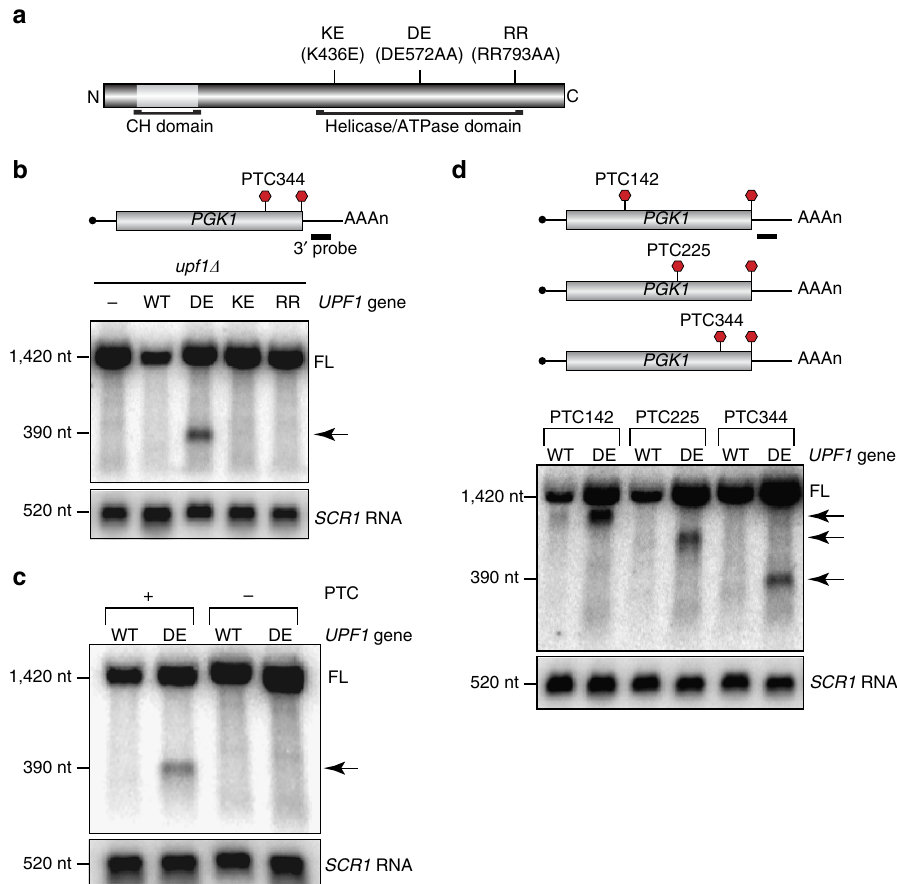
Figure 1 | Accumulation of a 3 0 RNA fragment from nonsense-containing mRNA in UPF1 ATP hydrolysis mutants. ( a ) Schematic diagram of point mutations within the C-terminal helicase domain of UPF1 that impair ATP binding (K436E), ATP hydrolysis (DE572AA) or RNA binding (RR793AA). The cysteine/histidine-rich domain (CH) within the N-terminus of UPF1 is indicated. ( b – d ) Northern blot analysis of PGK1 reporter mRNA in upf1 D cells ( (cid:2) ) complemented with wild-type (WT) or mutant UPF1 using a probe complementary to the mRNA 3 0 end. Reporter mRNA either harboured a PTC within its 416 codon open reading frame ( b – d ) or lacked a PTC ( c ; (cid:2) ). Full-length reporter mRNA (FL) and 3 0 RNA fragments (arrow) are indicated. RNA levels were normalized to NMD-insensitive SCR1 RNA. Results are representative of three independent experiments. Nt,